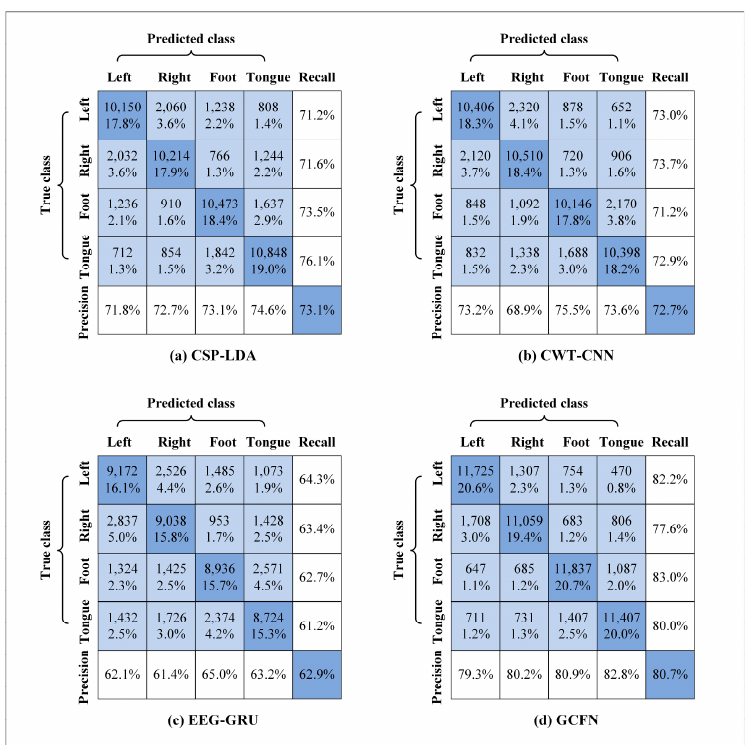
Figure 11. Confusion matrix for different models.